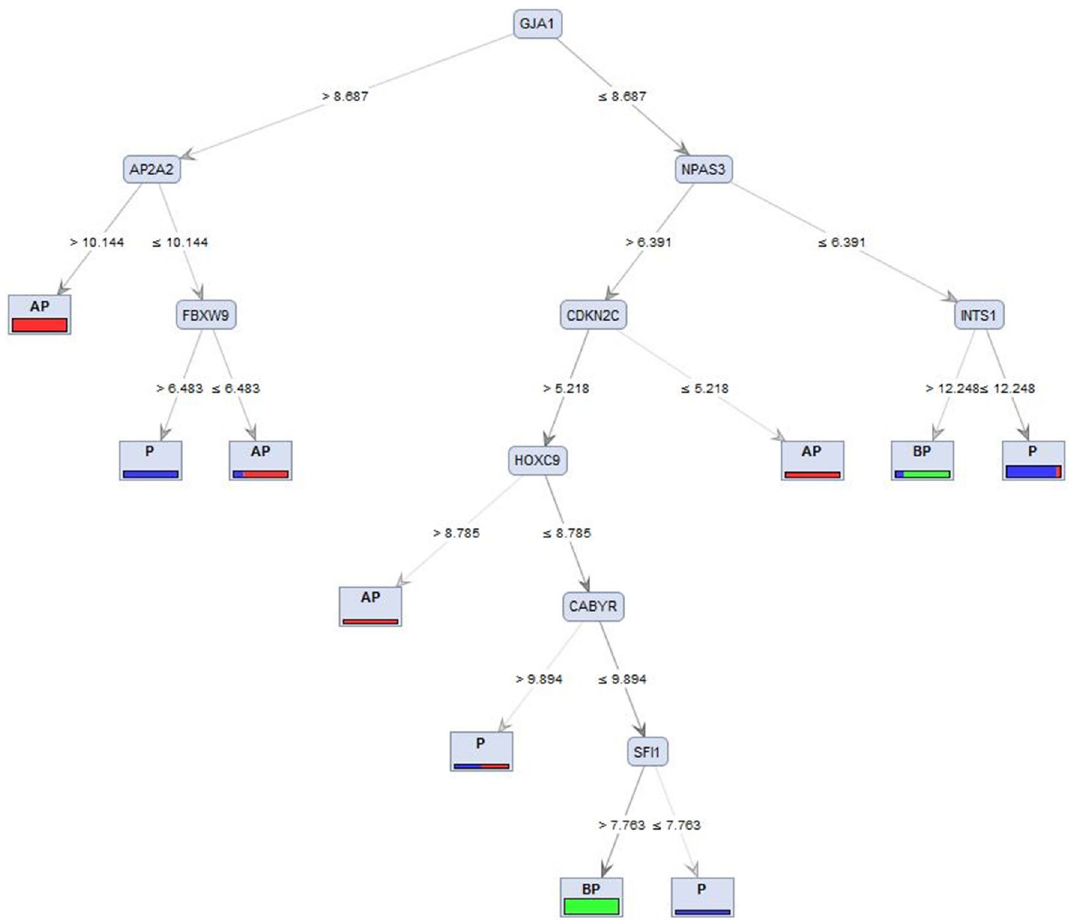
Figure 7. Graphical model of decision tree using Information Gain criterion based on hub genes in three different stages of lactation (Before Peak (BP), Peak (P), and After Peak